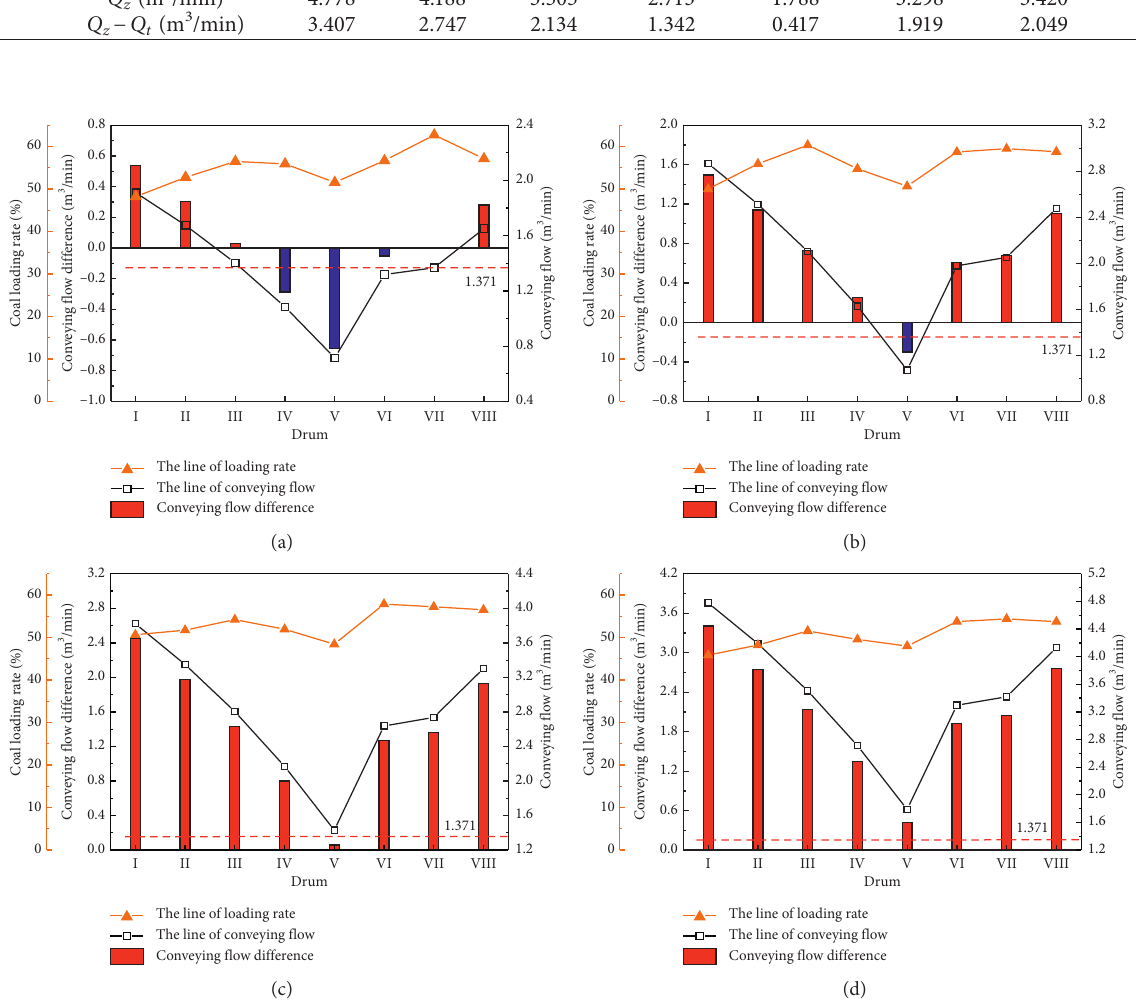
Figure 9: The relationship between the coal loading rate and coal conveying flow: (a) 40rpm, (b) 60rpm, (c) 80 rpm, and (d)